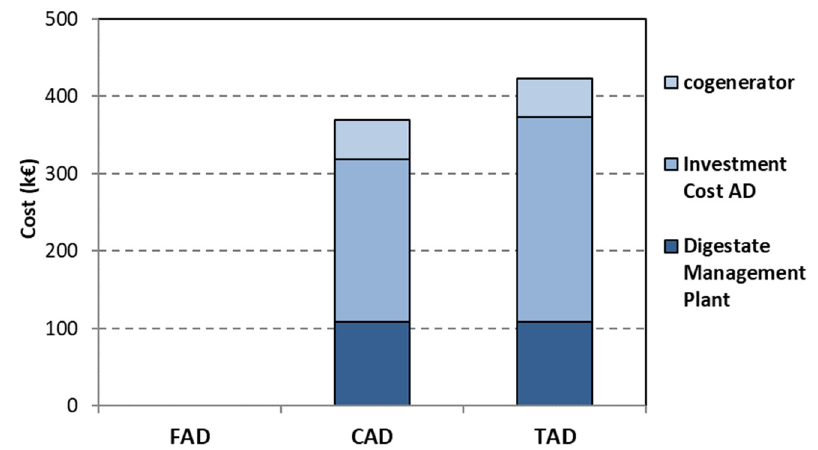
Figure 1. Cost contribution analysis: Capex.